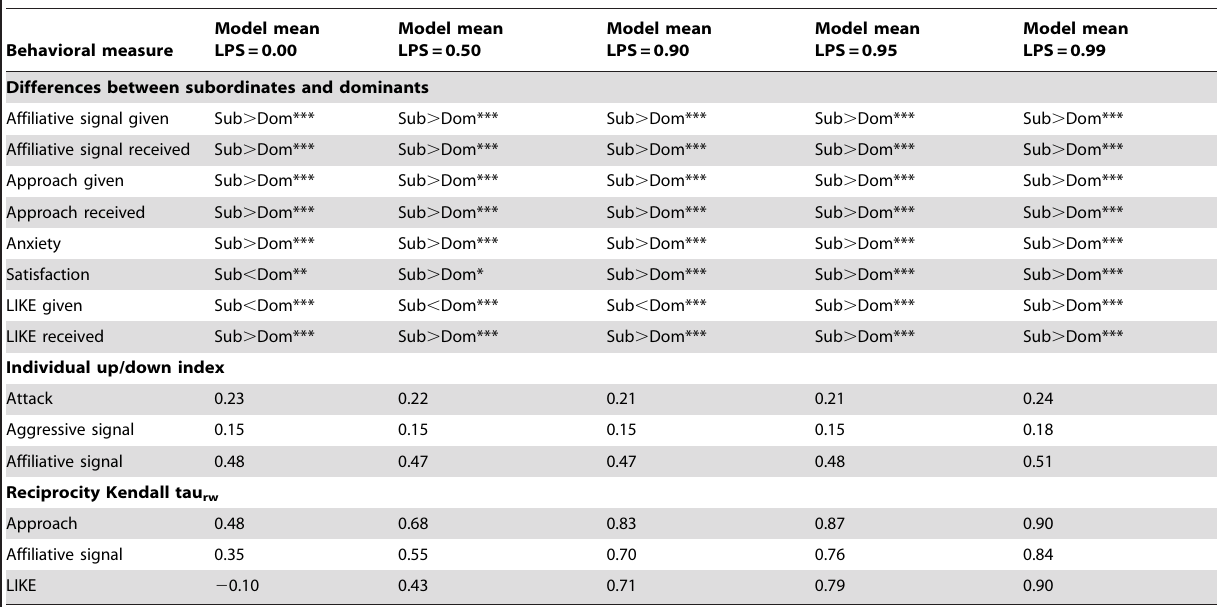
Table 5. Patterns emergent from our model.